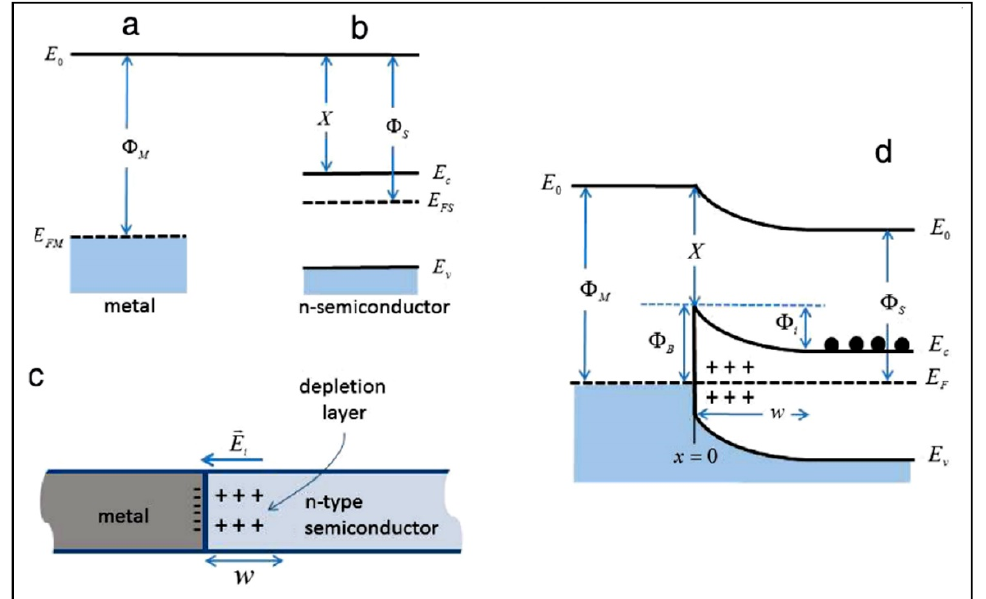
Figure 11. A Schottky barrier formed by a metal of higher work function contacting an n-type semiconductor. ( a ) Metal work function Φ M and Fermi energy E FM . ( b ) Semiconductor work function Φ S , electron affinity X and band structure with a bandgap between E c and E v and Fermi energy E FS . ( c ) Charge at the metal/semiconductor (M/S) junction. ( d ) Idealized equilibrium band diagram for the M/S junction. Φ i is the energy barrier to the flow of electrons (black dots) from the semiconductor to the metal, while Φ B is the Schottky barrier height for the electron flow in the opposite direction. W is the extension of the depletion layer. Reprinted with permission from reference [201]. Copyright 2015 Elsevier B.V.